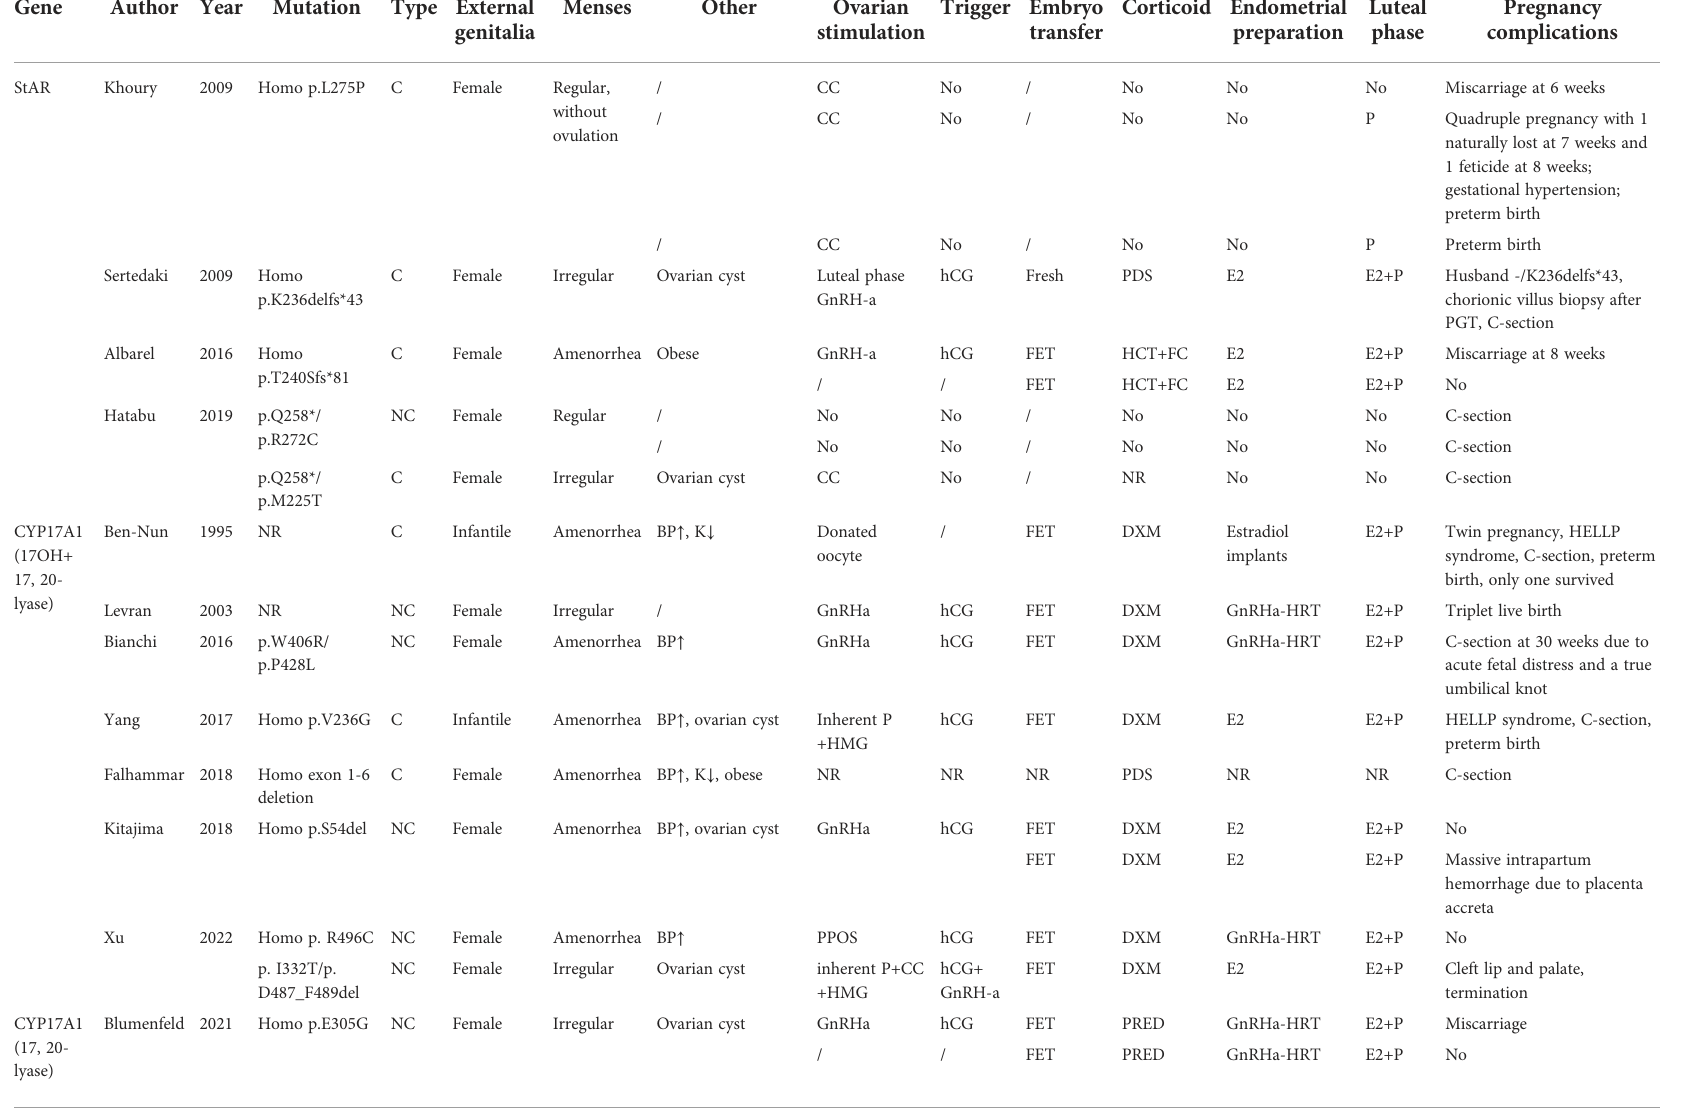
TABLE 1 Pregnancies in CAH other than 21-hydroxylase de fi